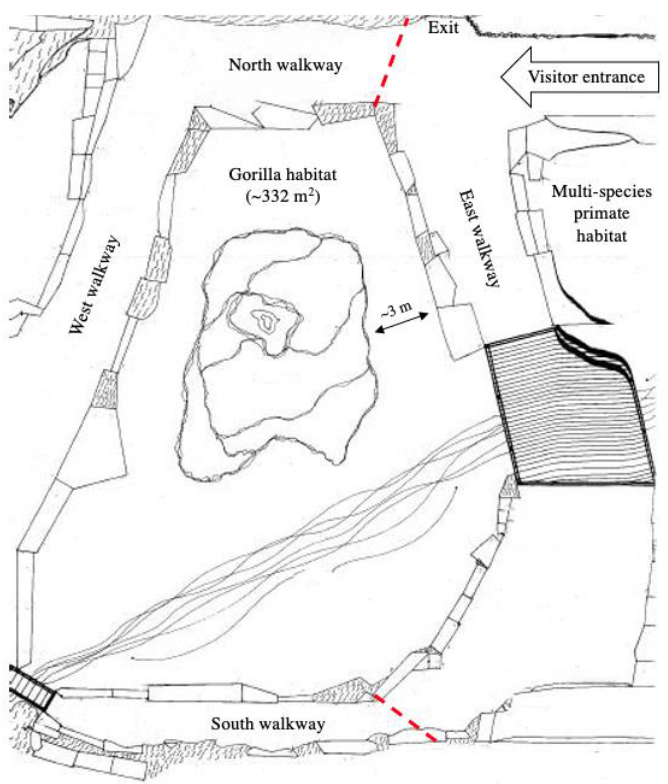
Gorilla Habitat Map